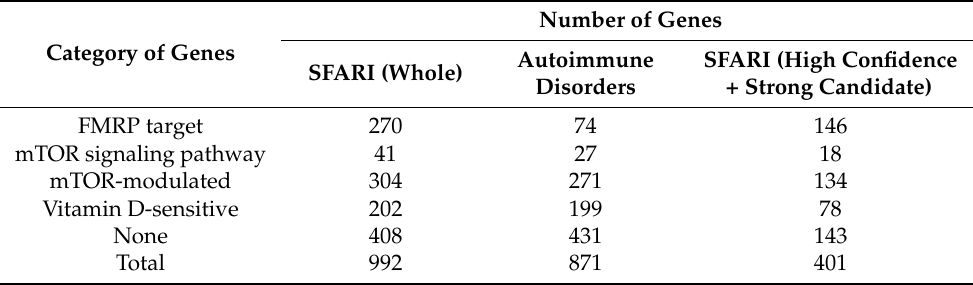
Table 1. A generalized table representing the relationships of four categories of genes: FMRP (fragile X mental retardation protein) target, mTOR (mechanistic target of rapamycin) signaling network, mTOR-modulated, and vitamin D-sensitive genes for SFARI (Simon’s Foundation Autism Research Initiative) Gene database and AID gene set.